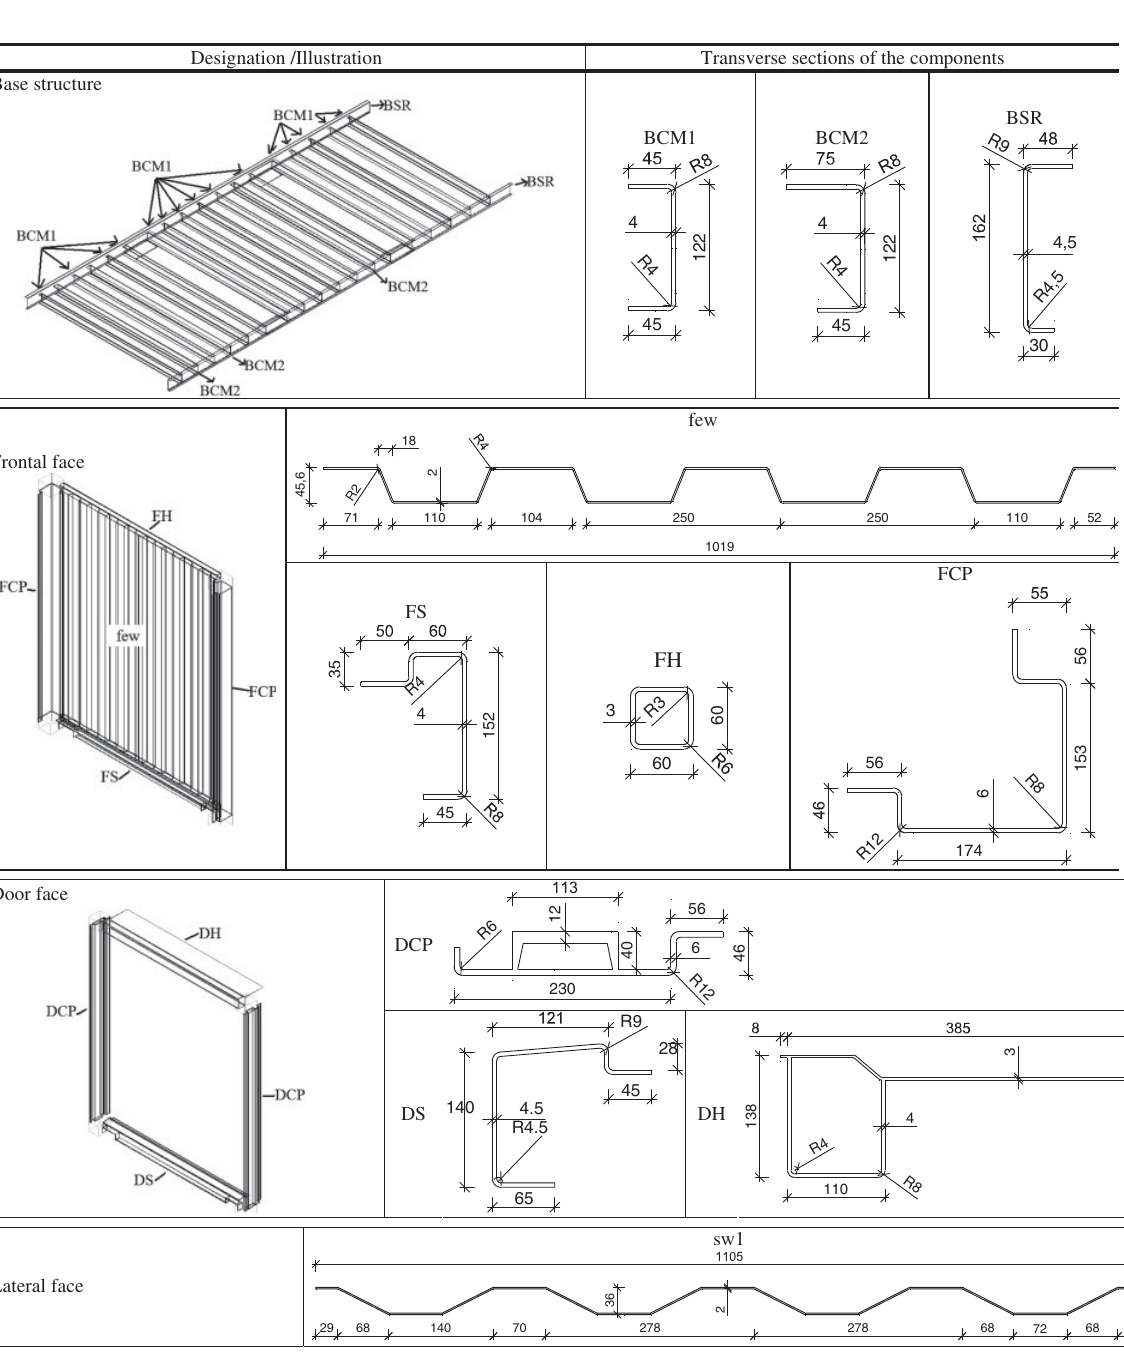
stnenopmocehtfosnoitcesesrevsnarTnoitartsullI/noitangiseD Base structure